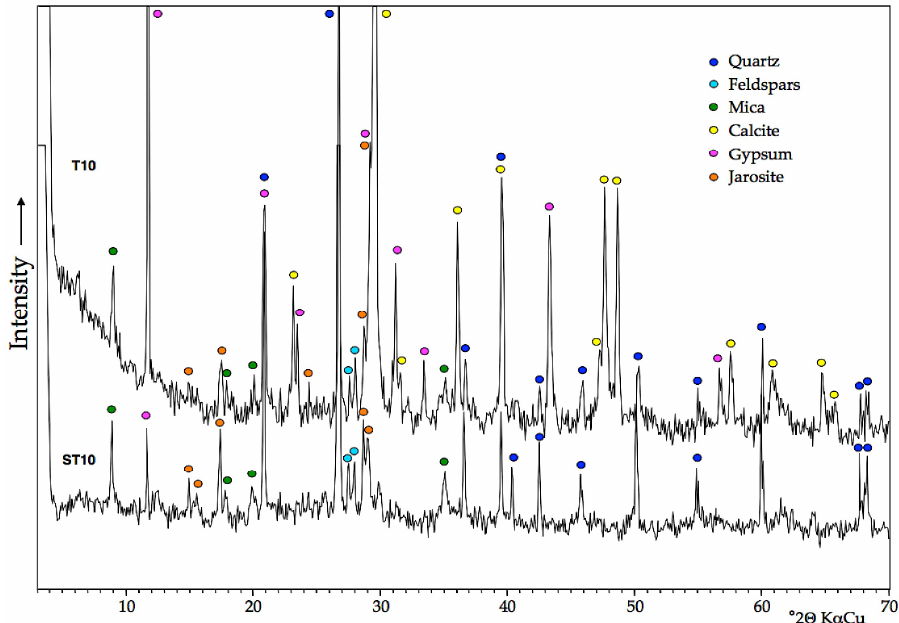
Figure 2. XRPD diffractograms of topsoil samples of amended soil (T10) and control soil (ST10).